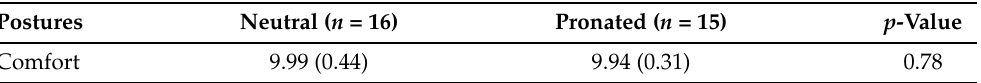
Table 6. The comfort score and p -value of the neutral and pronated forearm postures.